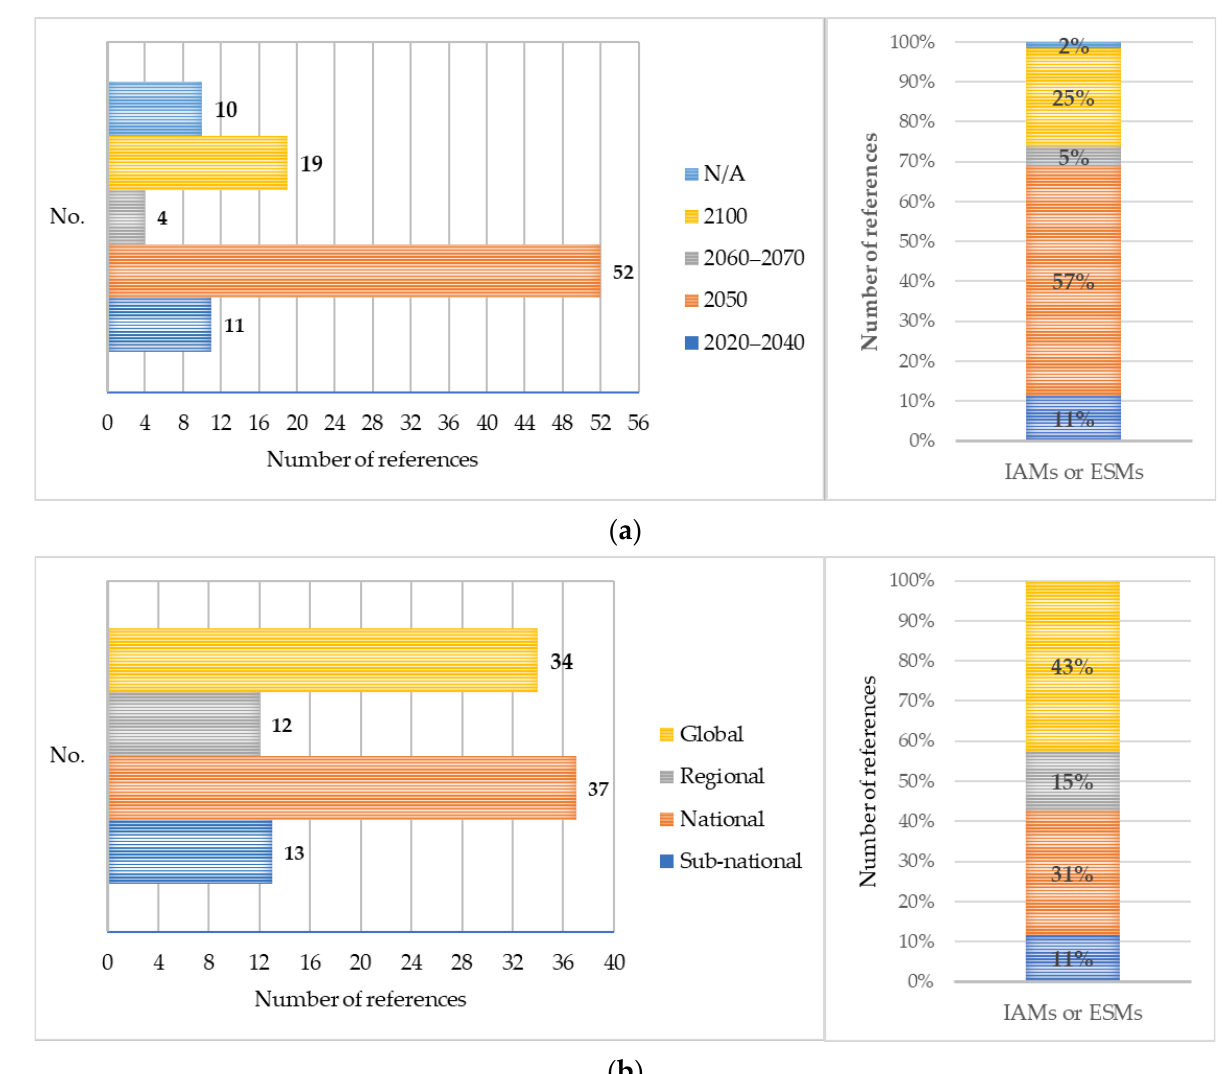
Figure 3. Descriptive statistics of the reviewed papers (for total sample and those employing IAM and ESM-based tools) with respect to the ( a ) time horizon and ( b ) spatial coverage of conducted modeling exercises.